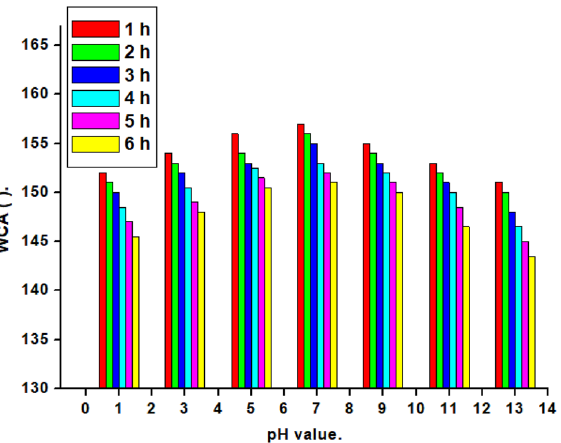
Figure 12. Influence of pH values on the modified textile fabric’s water contact angle at different immersion